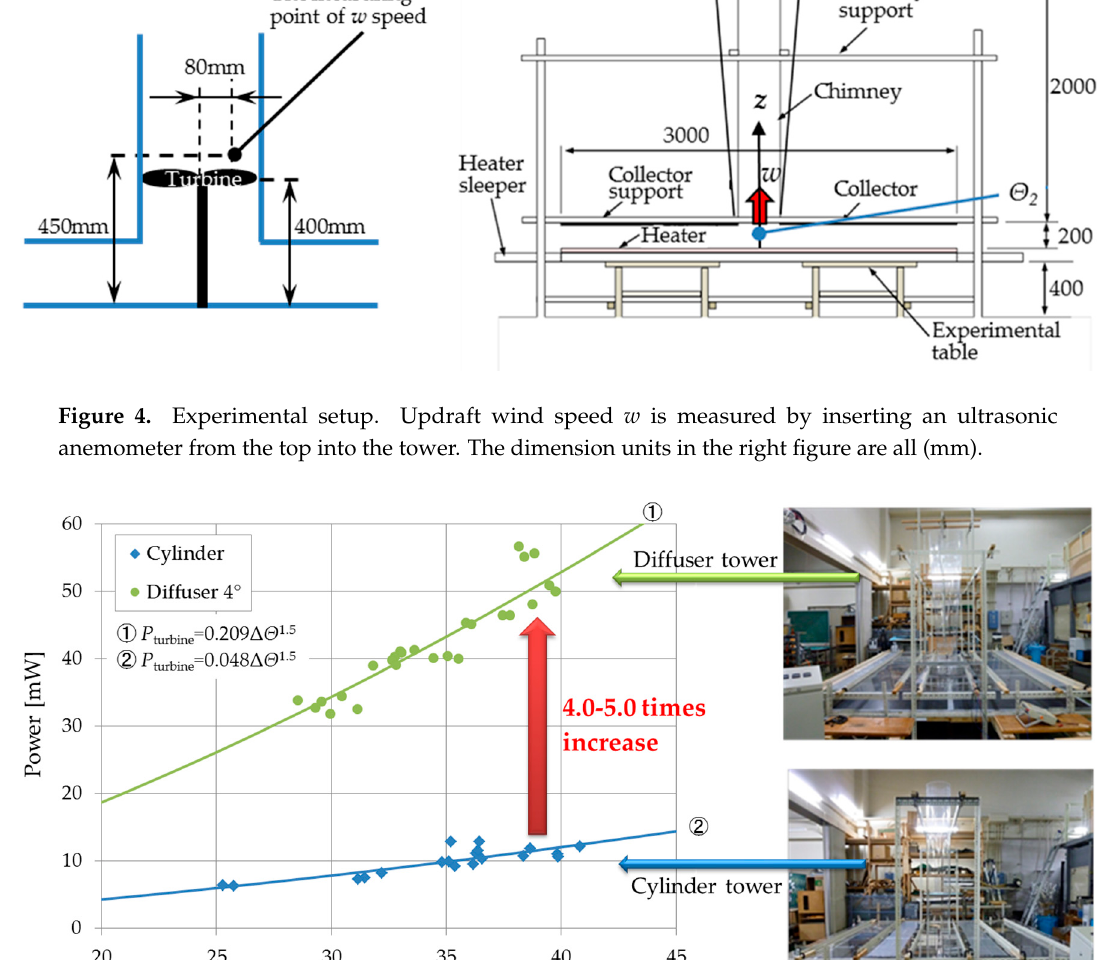
Figure 6. Updraft wind speed w vs. temperature difference ∆ Θ for diffuser model with tower height 2 m for each semi-open angle of 0° (cylinder), 2°, 4° and 6°.